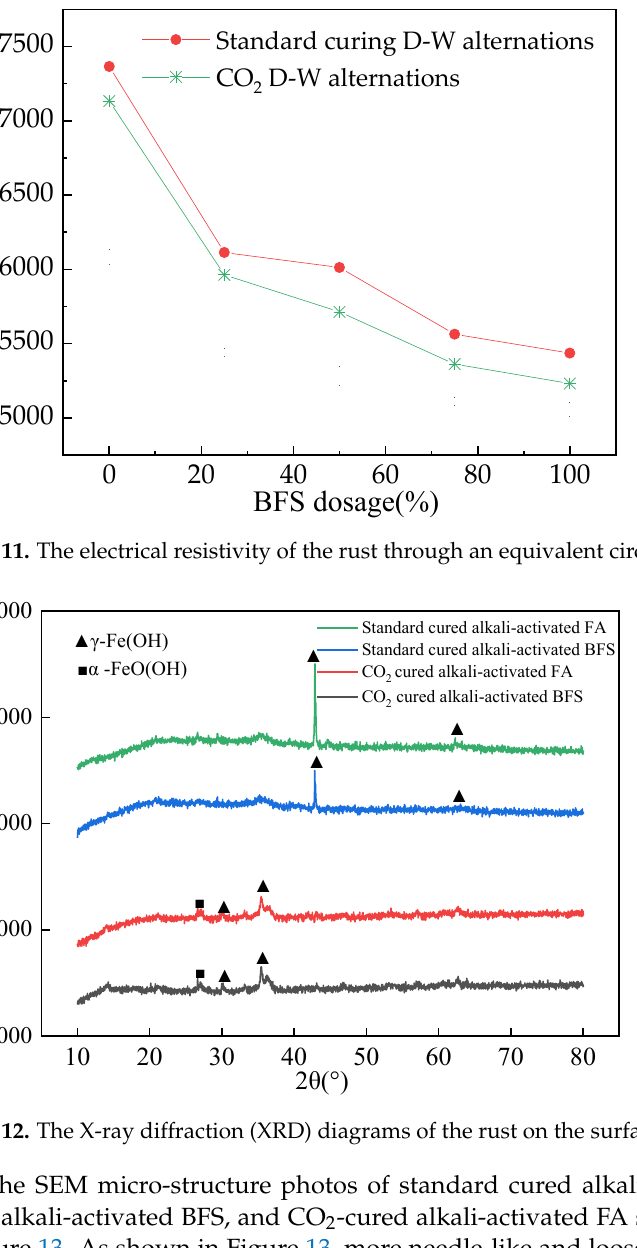
11 of 15 Table 5. The fitting results of the equivalent circuit diagram. Specimens